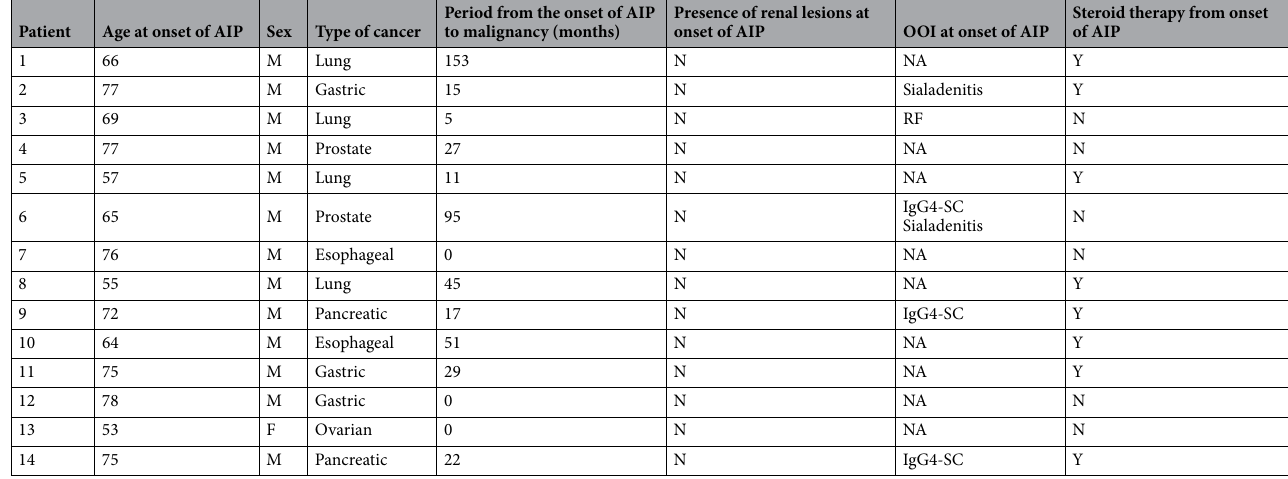
Table 4. Characteristics of 14 patients with malignancies. AIP autoimmune pancreatitis, OOI other organ involvement, RF retroperitoneal fibrosis, IgG4-SC IgG4-related sclerosing